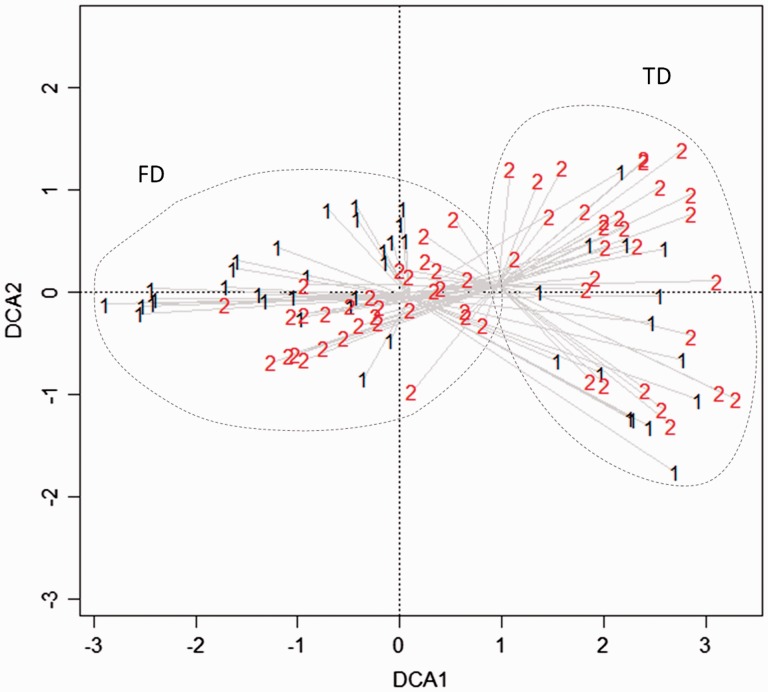
Ordination scatter diagram of sampled plots, using species as explanatory variables. Only the first two axes are represented. Number ‘1’: 2000s plots; number ‘2’: 2012 plots.